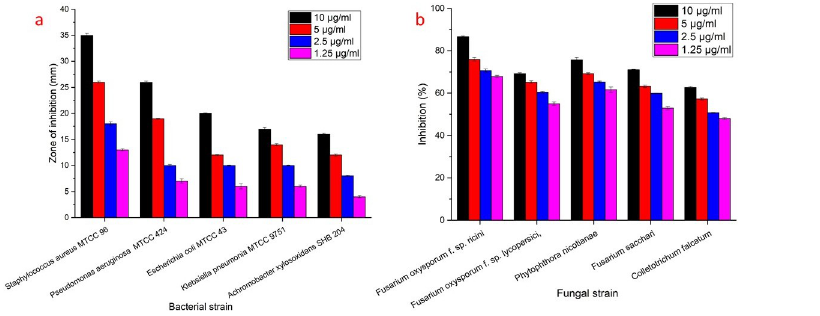
Fig 8. Antimicrobial activity of synthesized